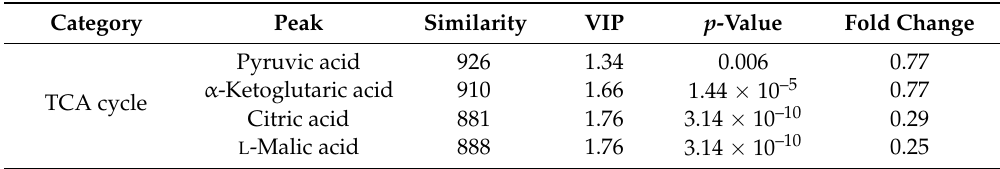
Table 3. Major metabolite changes in WBPH under heat stress. By GC-TOF-MS analyses of six biological replicates of heat-stressed and unstressed virus-free WBPH, the metabolites that had a VIP > 1.0 and p -value < 0.05 were considered to be significantly altered metabolites, and the metabolites involved in TCA cycle were selected to show in the